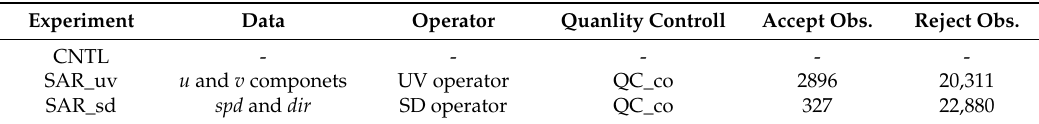
Figure 3. The accepted observtion wind vectors in the ( a ) SAR_sd and in the ( b ) SAR_uv experiments. The blue points are the wind vectors. Table 3. Details of the three